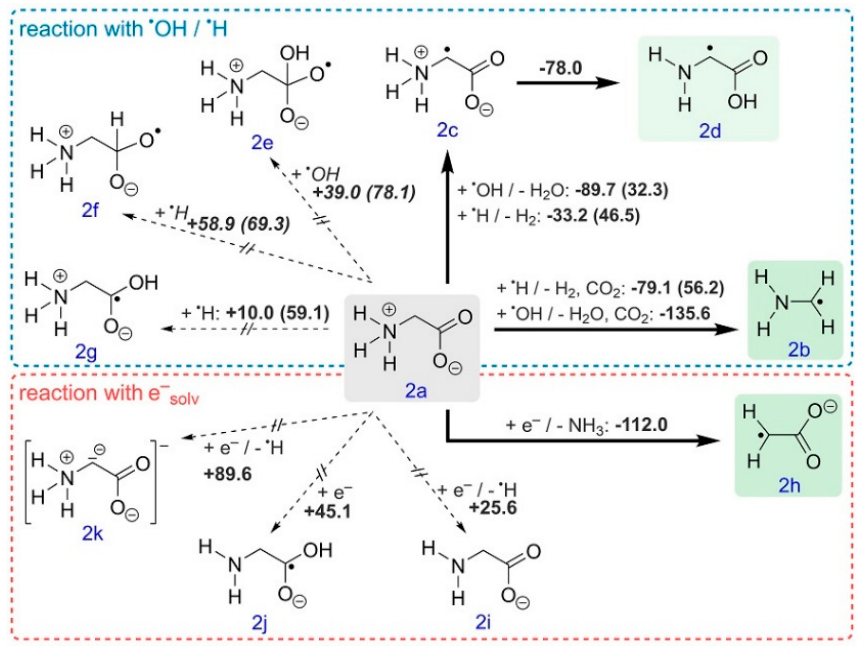
Scheme 4. Reactions of glycine with water radiolysis products. Most important for RIGI is 2b